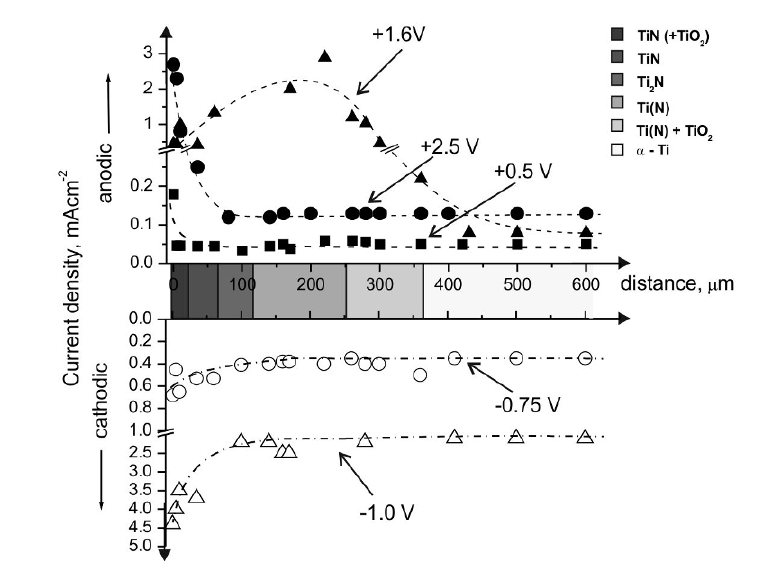
Figure 3. Depth profiles of cathodic- and anodic current densities at characteristic potentials: −1.0 V (hydride formation), −0.75 V (hydrogen evolution on TiH